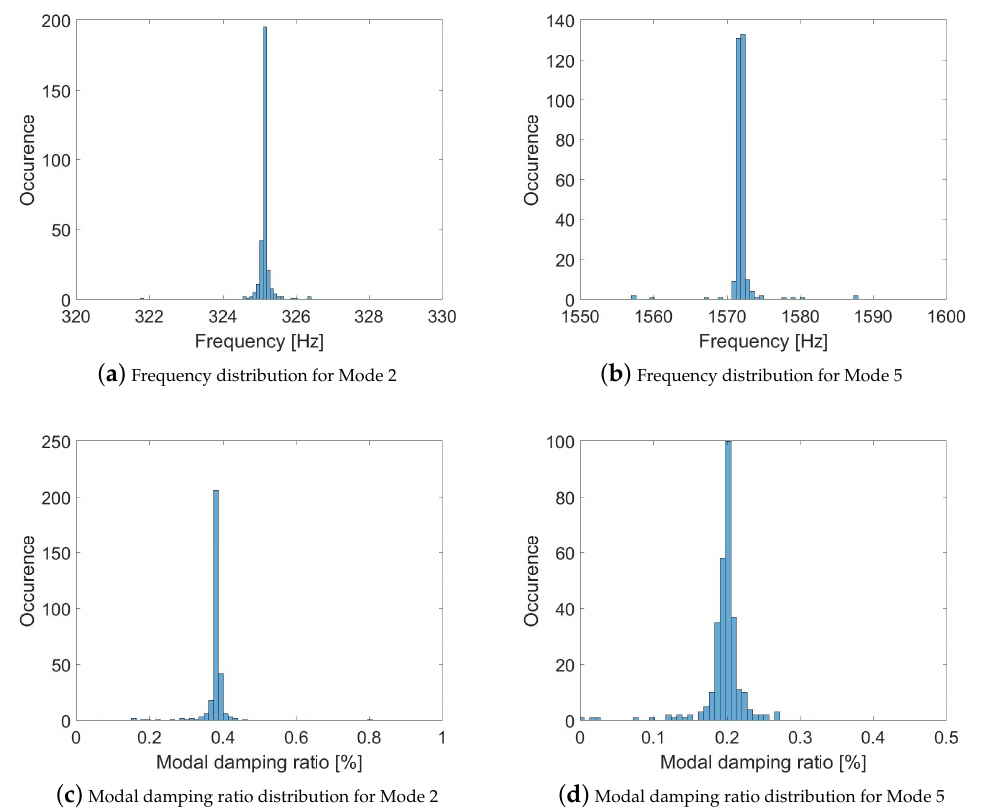
Figure 17. Distributions of frequencies and modal damping ratios obtained from the DIC measure- ments for Mode 2 and 5 of the clamped–clamped